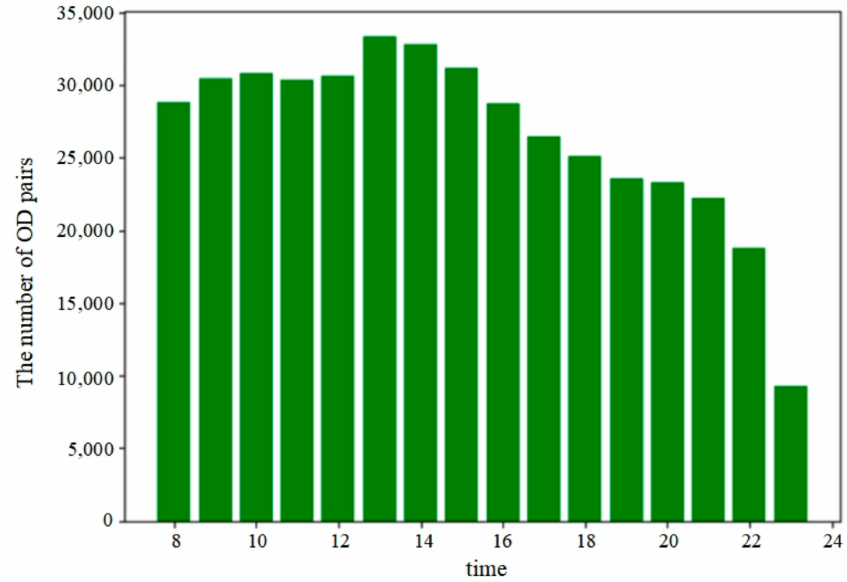
Figure 9. The number of OD pairs per